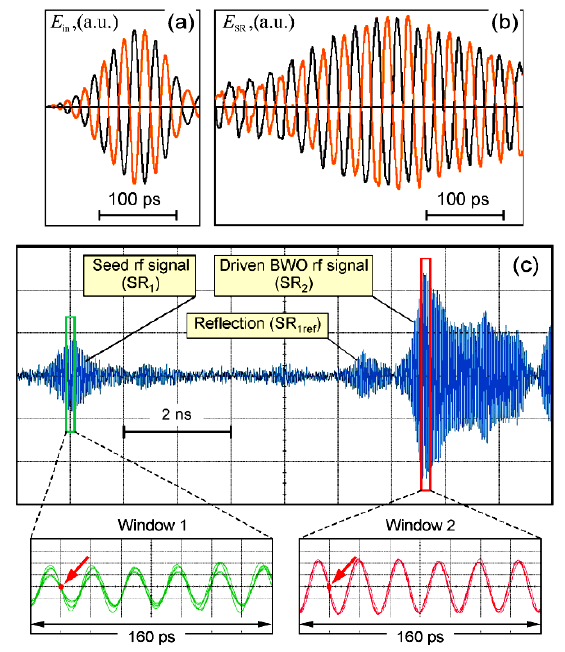
Fig. 4. (a) – Seed rf pulses (30 kW) with counter phases (0- black; (cid:4) – orange) and (b) phased response of driving 400-MW SR pulse (PIC-simulation). (c) – Experiment on